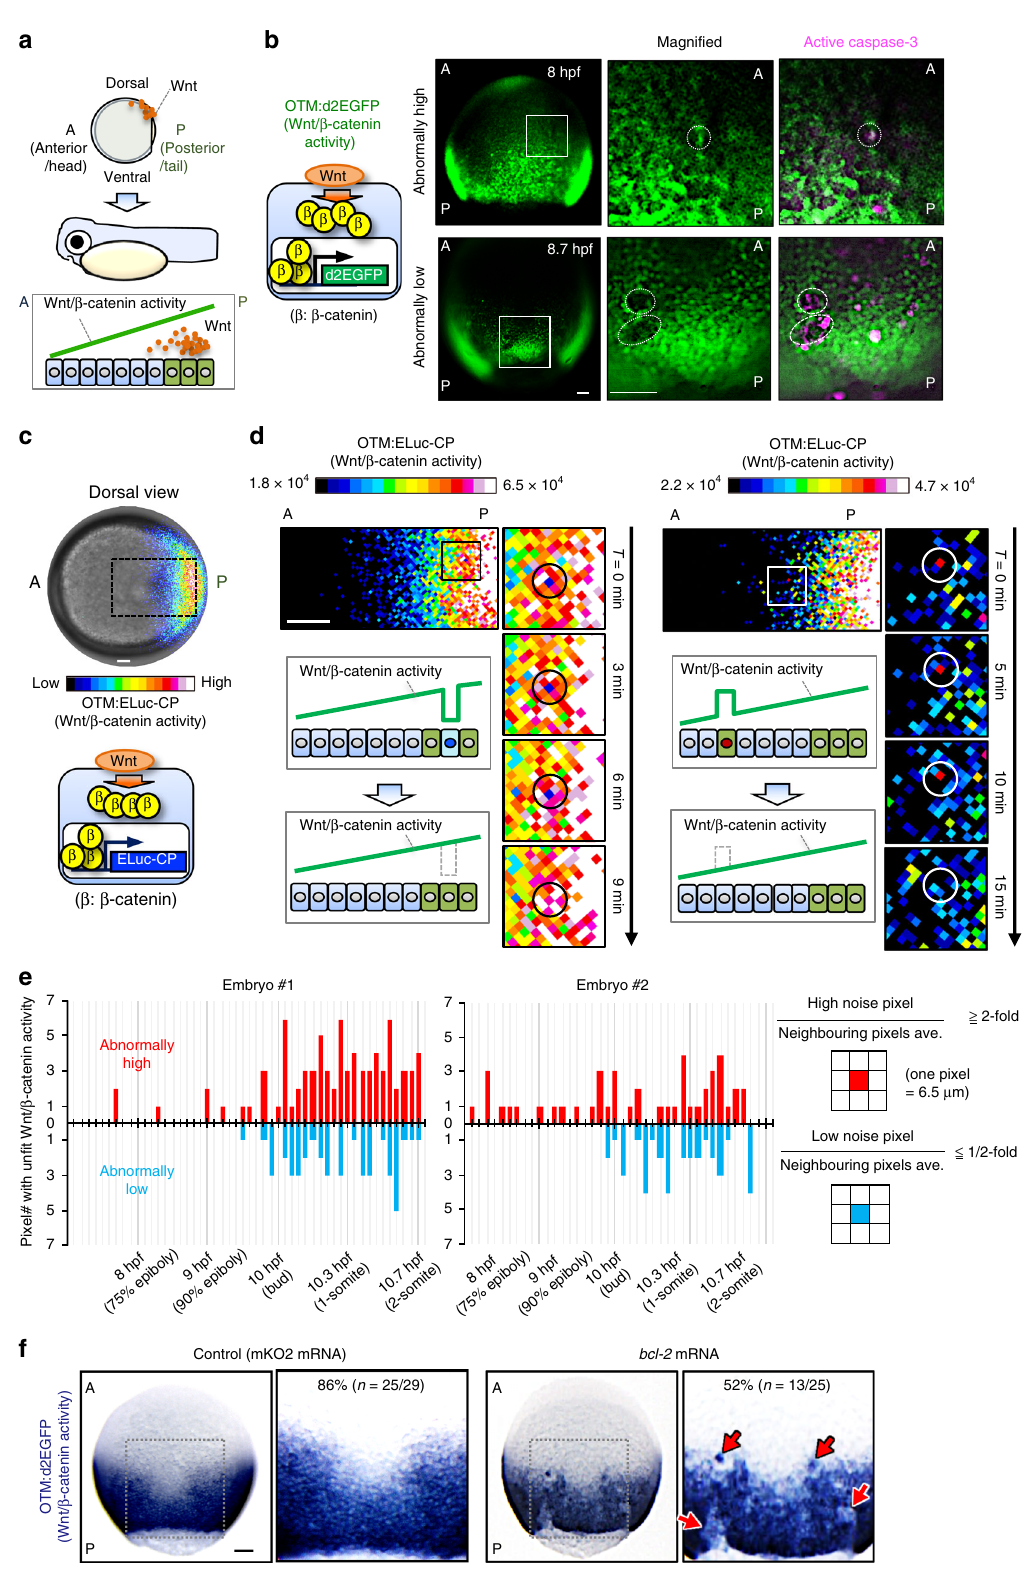
abnormally high or low Wnt/ β -catenin activity ef fi ciently activated caspase-3 in the Wnt/ β -catenin signalling-low anterior or signalling-high posterior region, respectively (Fig. 2g; Supple- mentary Fig. 3f). This result indicates that a large Wnt/ β -catenin activity differential between abnormal and neighbouring cells is